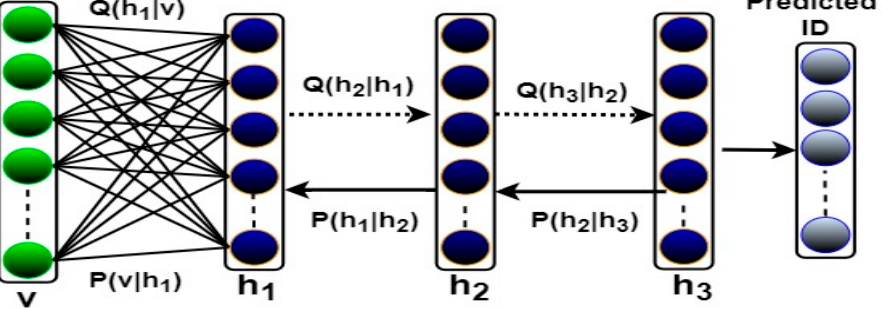
Figure 4. The main architecture of the developed DBN model for addressing person ReID problems.